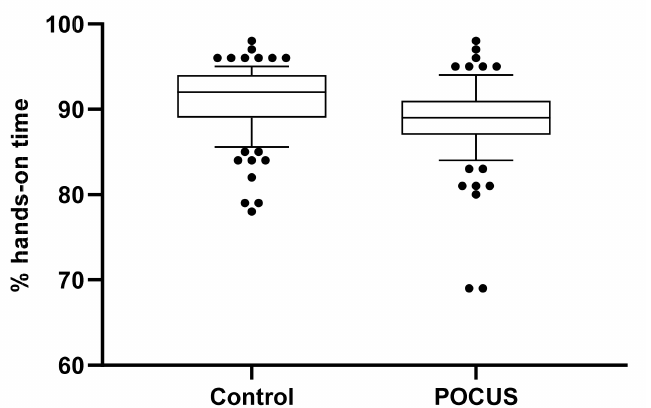
Figure 3. Box and whisker plot of the percentage hands-on time. Boxes represent medians and interquartile range; whiskers delineate the 10th and 90th percentile respectively. Dots indicate values outside the 10th and 90th percentile. Left bar = control group (no POCUS available); right bar = intervention group with POCUS available. Overall hands-on times differed significantly between the groups ( p <